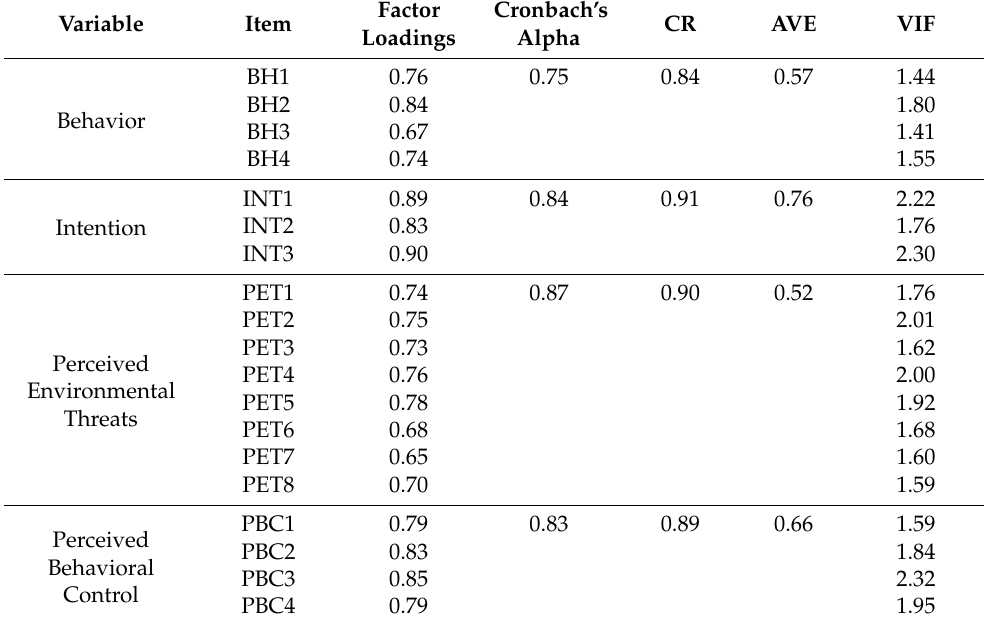
Table 3. Reliability and Validity of Measurement Items.